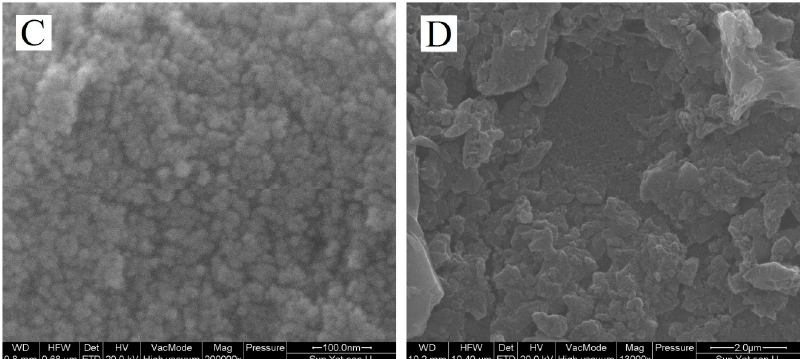
Figure 1. SEM images of MWCNTs − OH ( A ), CMK − 8 ( B and C for low and high magnifications, respectively) and MWCNTs − OH / CMK − 8 ( D ).